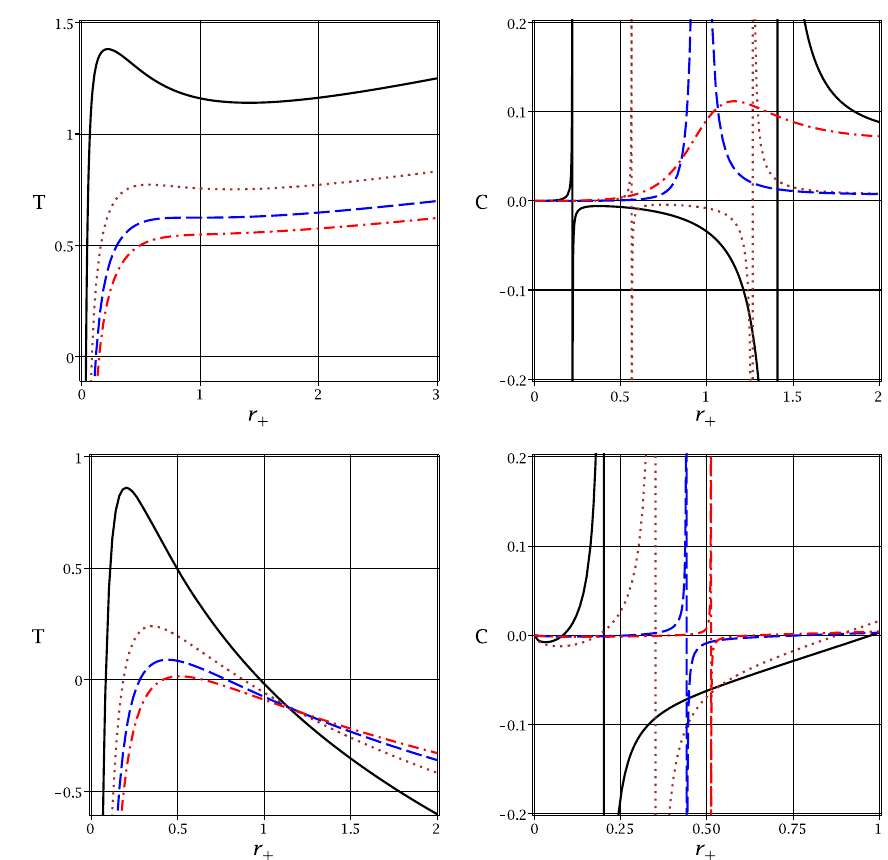
Fig. 7 T (left panels) and C (right panels) versus r + for k = 1, m = 5, (cid:16) = − 1, b = 1, q = 1, β = 1, g (ε) = 1 . 1, f (ε) = 0 . 2 (continuous line), f (ε) = 0 . 3 (dotted line), f (ε) = 0 . 3567 (dashed line) and f (ε) = 0 . 4. Upper panels: α = 0 . 5; lower panel: α = 1 .